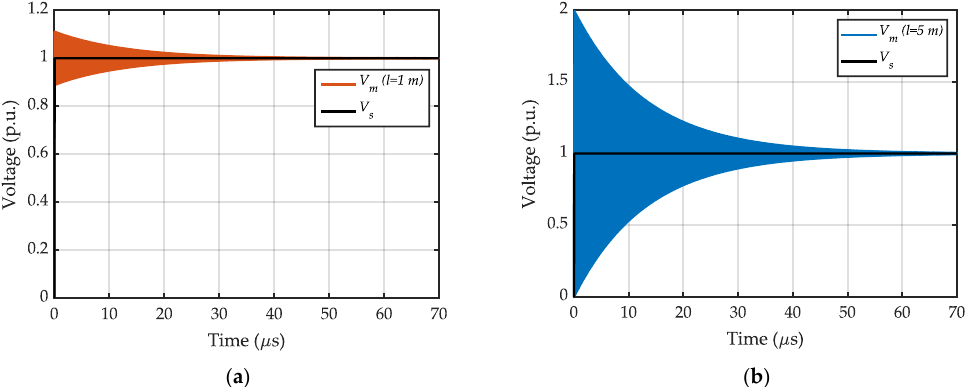
Figure 3. The voltage at motor terminals ( 𝑉 𝑚 ) when the motor is fed by a step voltage with 𝑡 𝑟 = 30 ns through a cable with ( a ) 𝑙 = 1 m; ( b ) 𝑙 = 5 m.